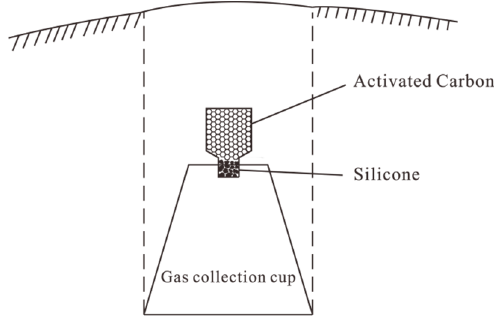
Figure 10. Diagram of the Activated-Carbon Adsorber